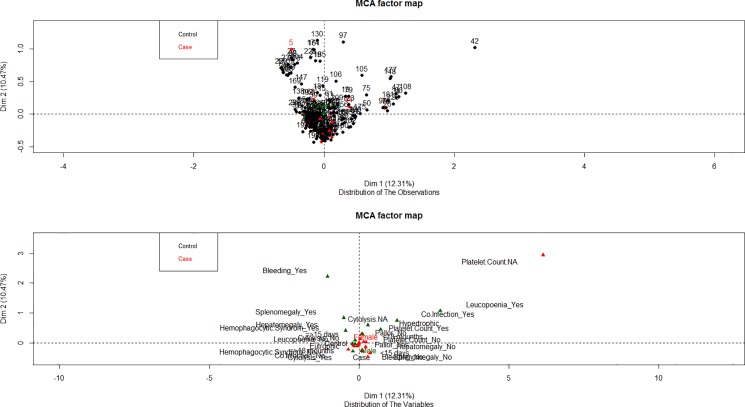
Representation of the categorized clinical data and variables versus morbidity in 2 dimensions resulting from the MCA, in order to describe potential grouping either for individual observations or variables.